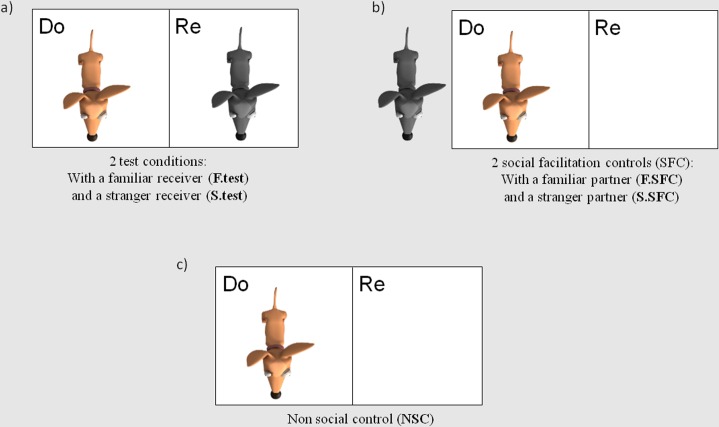
Location of the donor (Do) and receiver (Re) for each condition.Figure taken from Quervel-Chaumette et al [21].